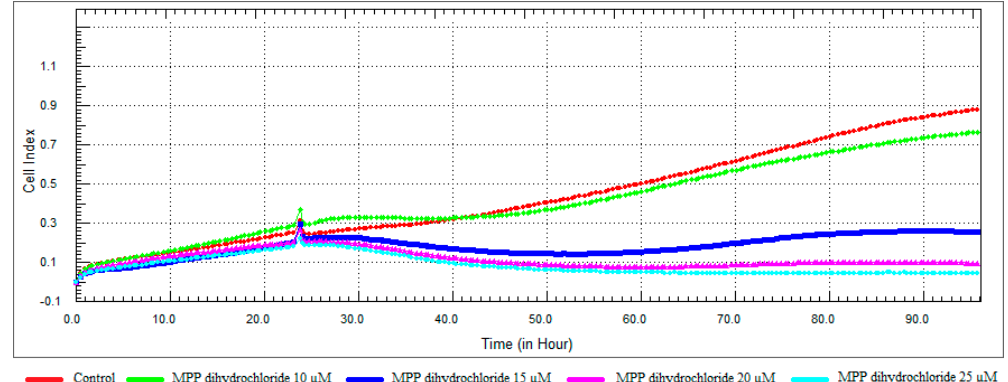
Figure 9. Dose and time-dependent cytotoxic effect and alteration of CI of MPP dihydrochloride determined by xCELLigence system: Effect of MPP dihydrochloride on proliferation of RL95-2 cell. Cells were treated with various concentrations of MPP dihydrochloride for 72 h. The CI was calculated from four repeated measurements.